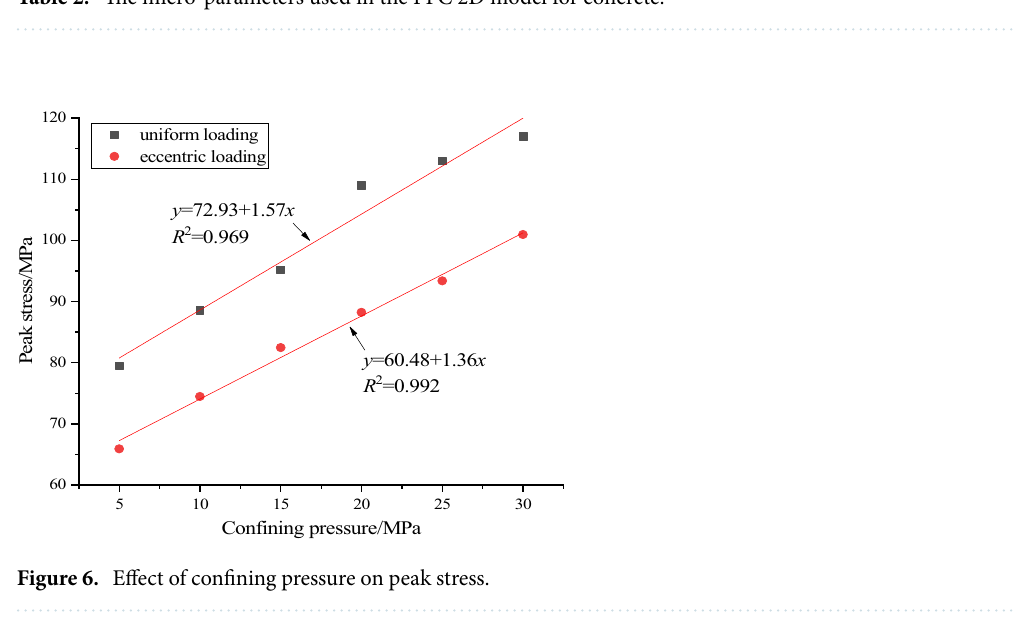
Table 2. The micro-parameters used in the PFC 2D model for concrete.